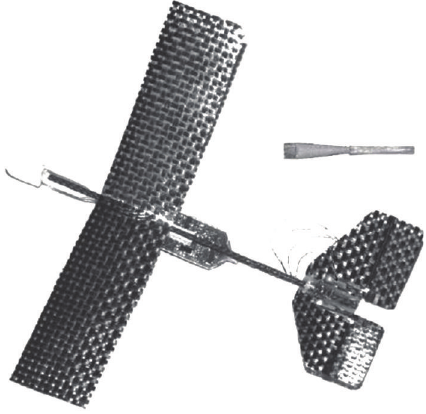
Figure 14: Palm-size micro glider